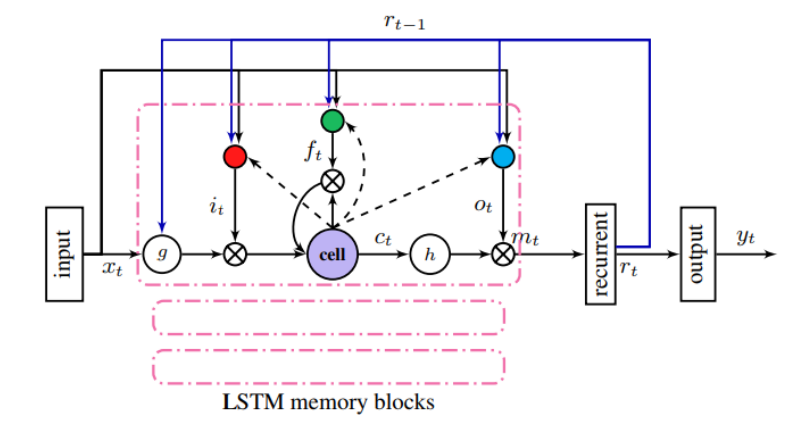
Figure 2. LSTM recurrent network scheme: the current state of the network depends on the previous state and the input, which are weighted by gate functions.